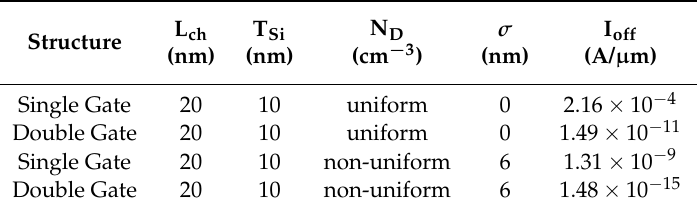
Table 3. Comparison between SGJLT and Double Gate (DGJLT) in terms of I of f for uniform (1 × 10 19 cm − 3 ) and non-uniform (Gaussian) doping concentration [43]. T Si is the device layer thickness. L ch Structure